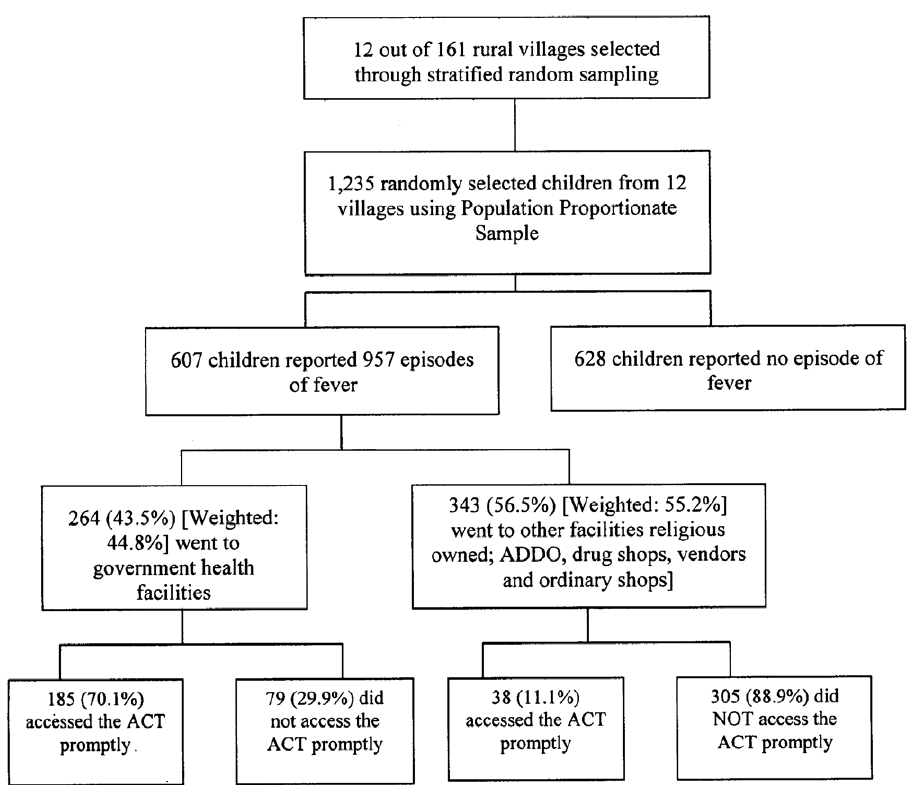
Figure 1. Flowchart showing the number of enrolled children by type of provider sought, treatment given and promptness of access to artemisinin combined therapy.